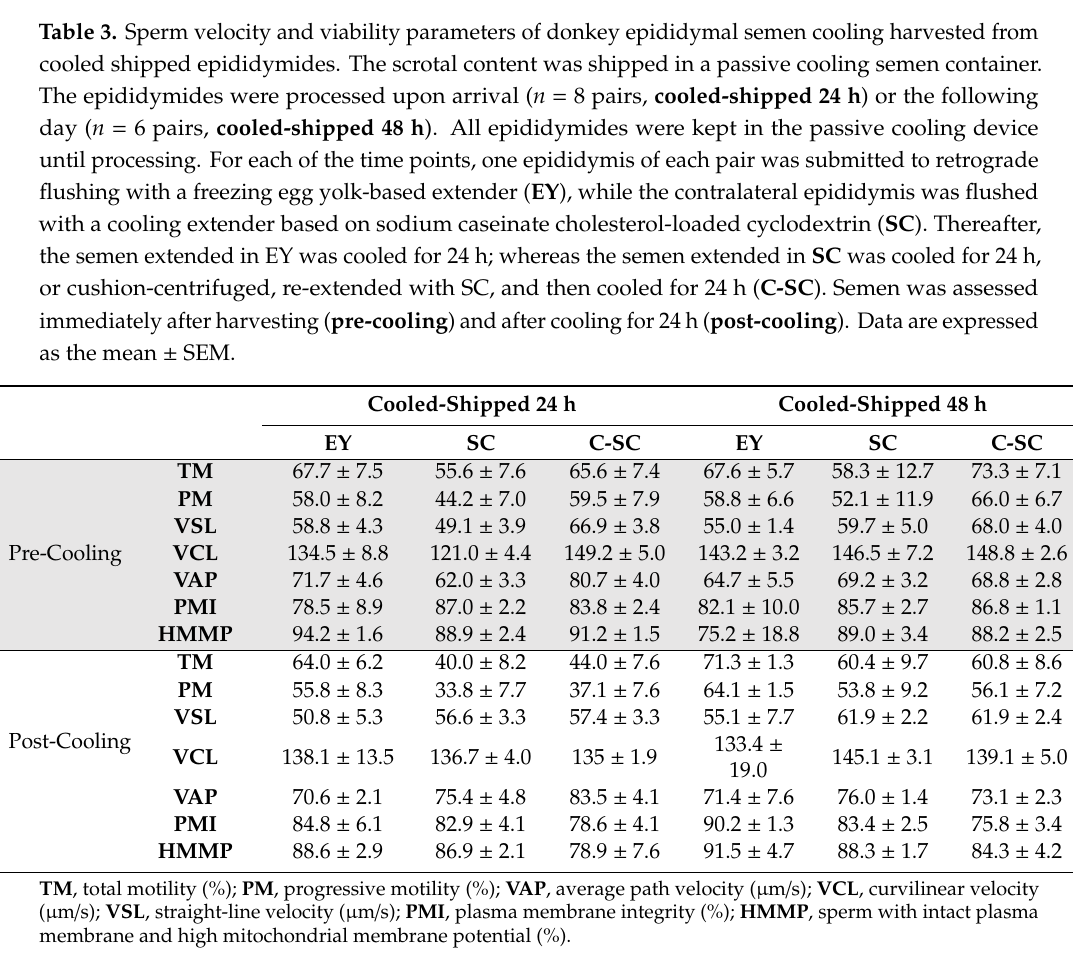
Table 3. Sperm velocity and viability parameters of donkey epididymal semen cooling harvested